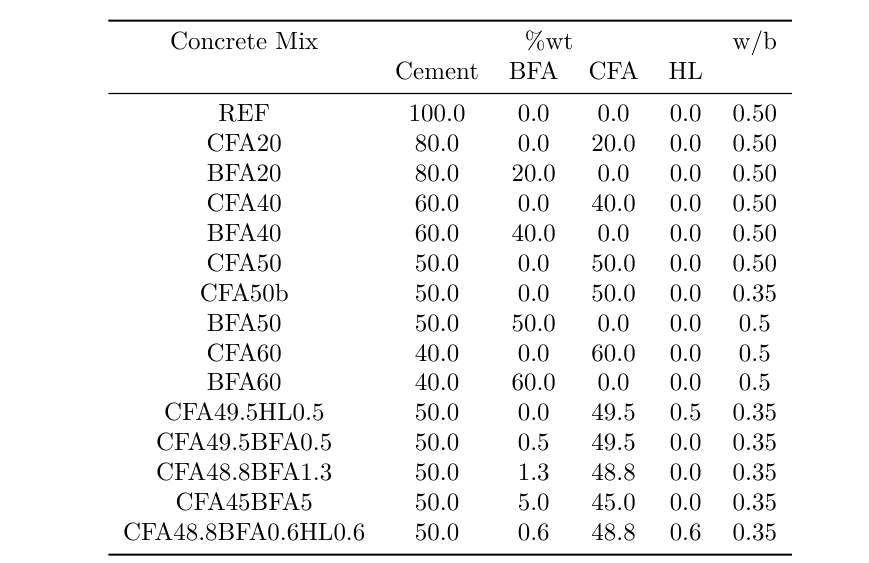
Table 1. Binder fraction and water/binder ratio used in the concrete formulations